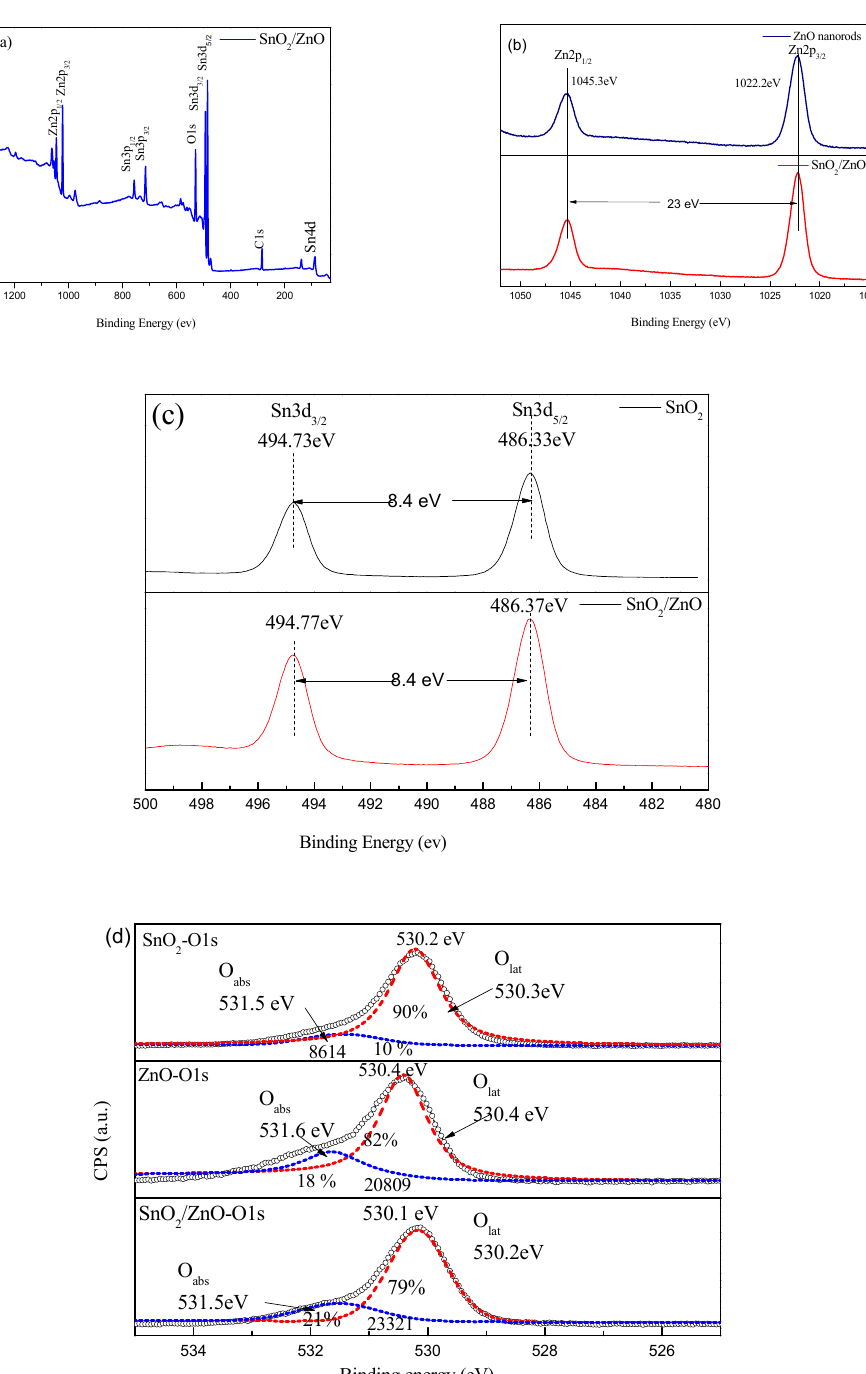
Figure 5. XPS spectra of SnO 2 /ZnO 3D hetero-nanofibers. ( a ) XPS spectra of SnO 2 /ZnO hetero-nanofibers. ( b ) XPS spectra of the Zn2p in ZnO and SnO 2 /ZnO. ( c ) XPS spectra of the Sn3d in SnO 2 and SnO 2 /ZnO. ( d ) XPS spectra of the O1s in the SnO 2 , ZnO, and SnO 2 /ZnO 3D hetero-nanofibers.